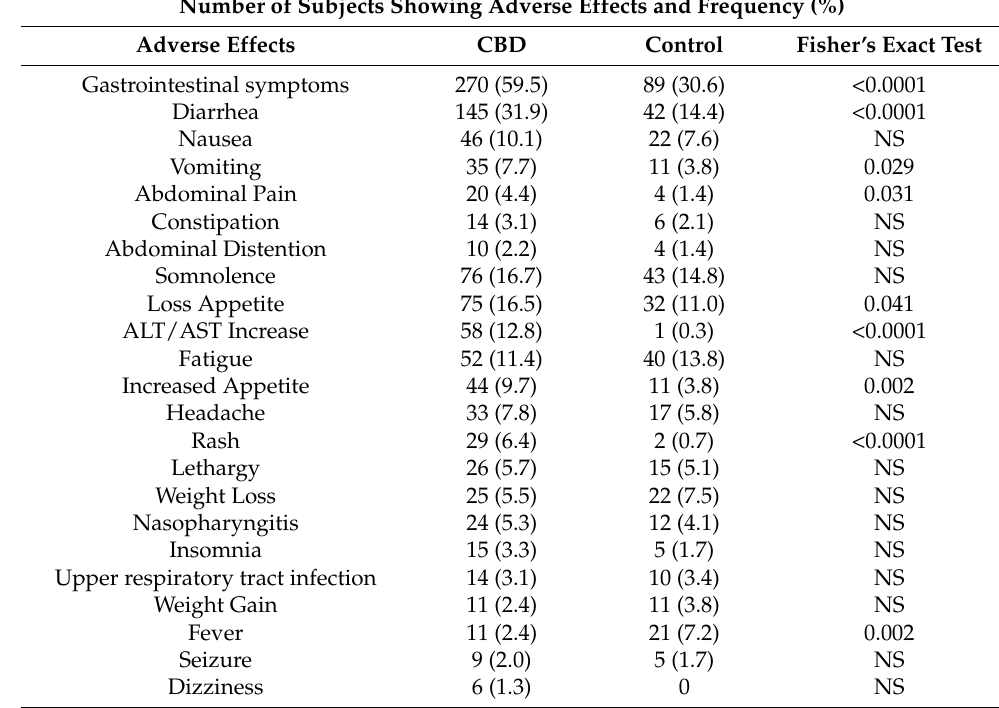
Table 2. The most common adverse effects reported in clinical trials on Cannabidiol. Number of Subjects Showing Adverse Effects and Frequency (%) Adverse